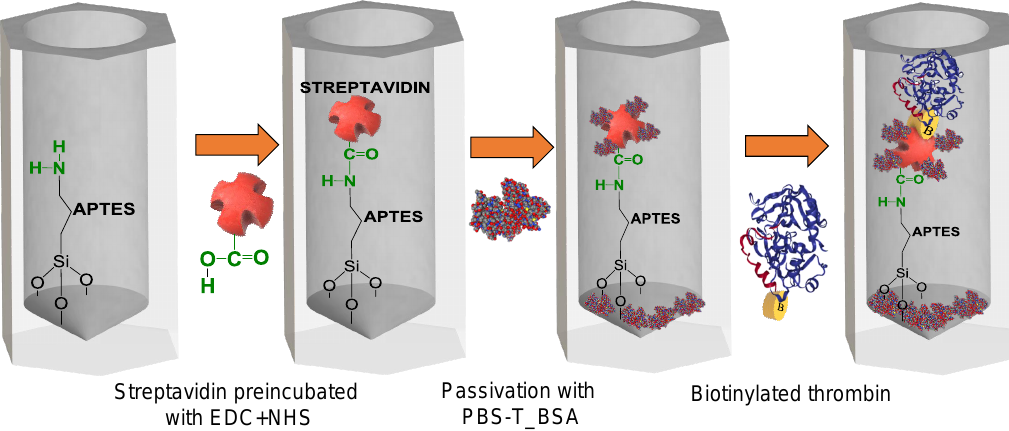
Figure 3. Schematics of the different NAA modification steps in the real-time monitoring of biotinylated thrombin attachment